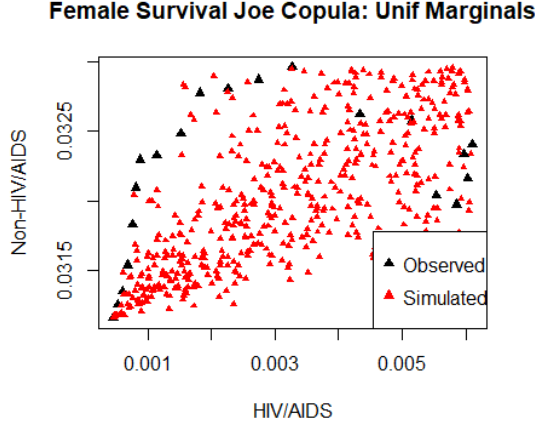
Figure 12. Uniform marginal distribution for females.